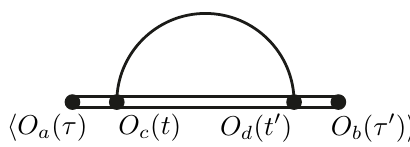
O a ( (cid:28) ) O b ( (cid:28) 0 ) corresponding h i